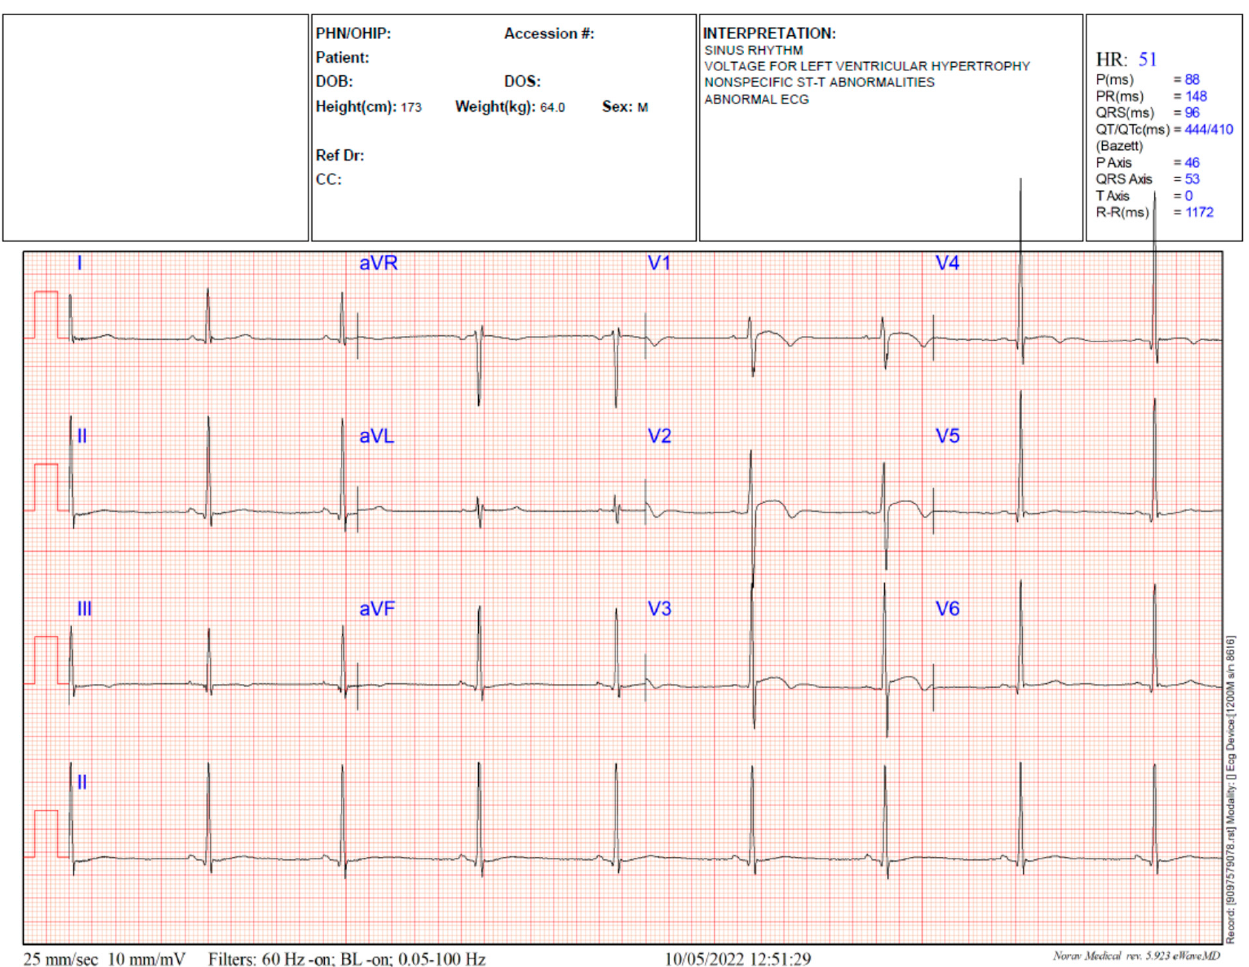
Figure 1. ECG of patient. Abnormalities interpreted as: Sinus Rhythm, voltage for left ventricular hypertrophy, non-specific ST-T abnormalities. Abnormal ECG.